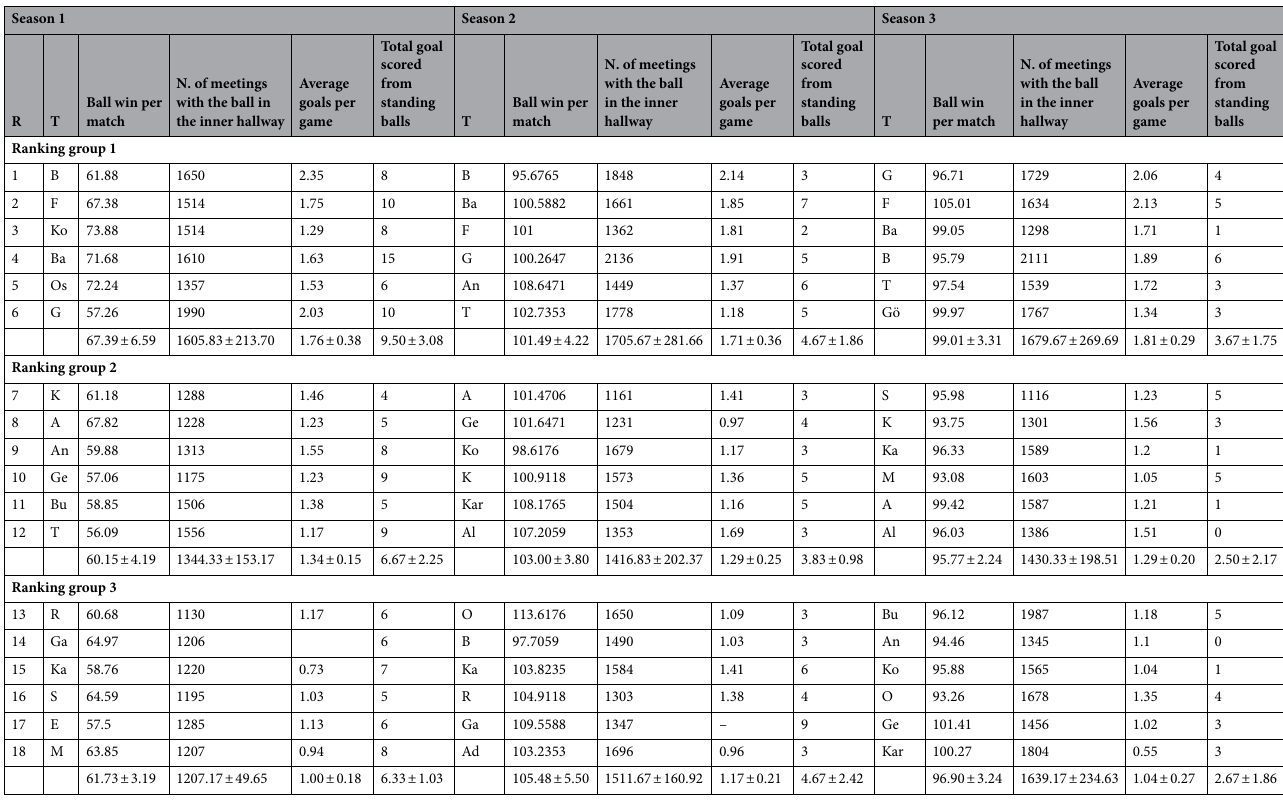
Table 4. Technical data of the player during the match [Ball win per match. Number of meeting with the ball in the inner hallway. Average goals per game and Total goal scored from standing balls (mean and SE)] as a function of Ranking group and Season Condition. Data are presented as means and standard deviations. TD: Total Distance; THID: Total high intensity running distance; TS: Total number of sprints; TSD: Total sprint distance; R: Ranking; Teams: Beşiktaş (B); Fenerbahçe (F); Konyasport (Ko); Başakşehir (Ba); Osmanlıspor (O); Galatasaray (G); Kasımpaşa (K); Akhisar (A); Antalyaspor (An); Gençlerbirliği (Ge); Bursaspor (Bu); Trabzonspor (T); Rizespor (R); Gaziantepspor (Ga); Kayserispor (Ka); Sivasspor (S); Eskişehirspor (E); Mersin İY (M); Karabükspor (Kar); Alanyaspor (Al); Adanaspor (Ad). Göztepe (Gö). and Malatyaspor